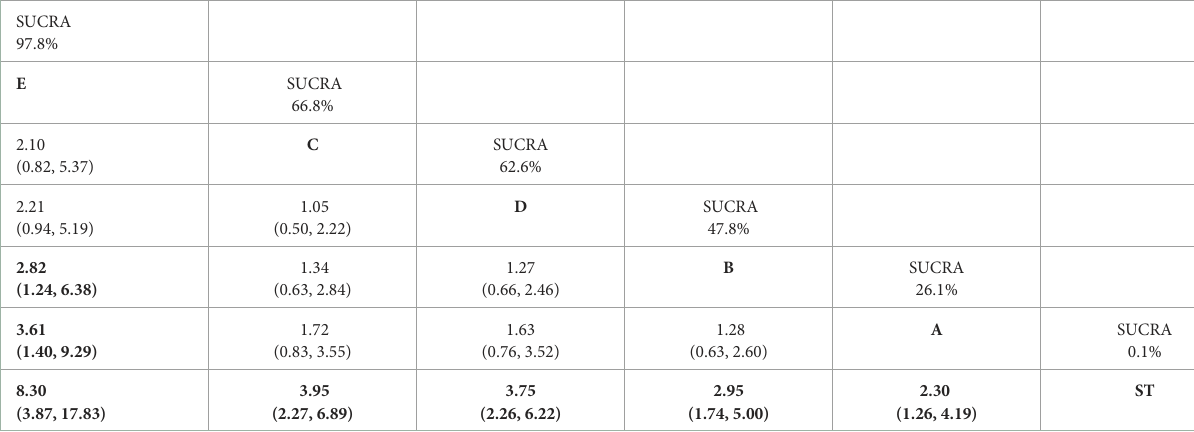
TABLE 2 Relative effect sizes of CER efficacy after the intervention. SUCRA 97.8%